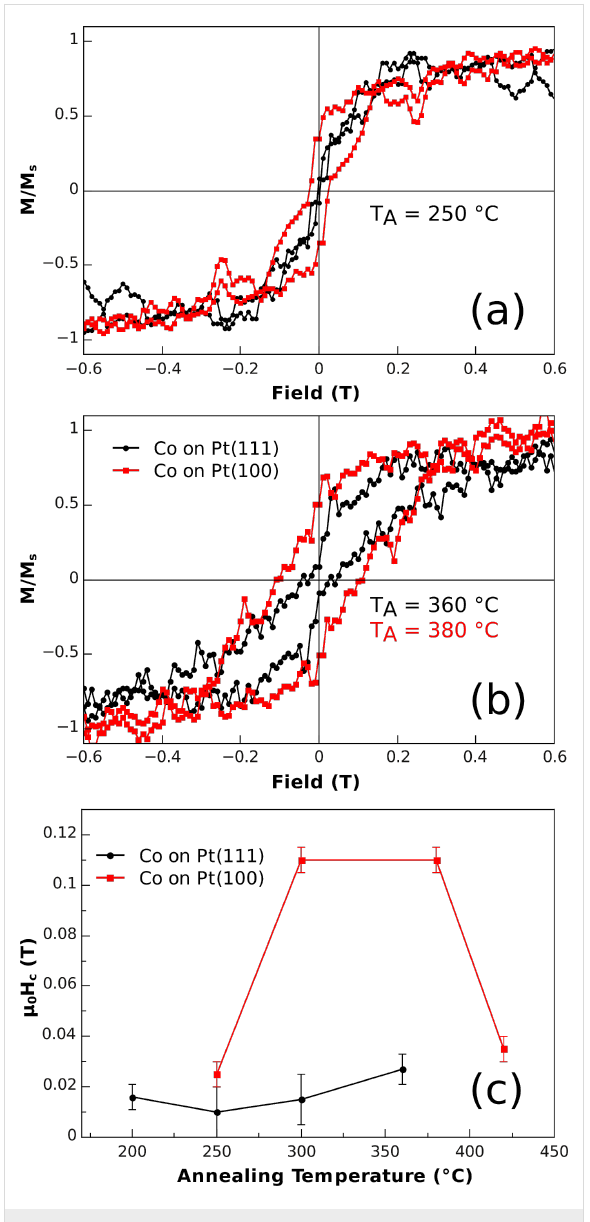
Figure 5: Element specific XMCD hysteresis loops measured at the Co L 3 maximum dichroic signal at T = 12 K and out-of-plane geometry for Co NPs on Pt(100) and Pt(111) films after annealing at (a) T A = 250 °C and (b) 360 °C on Pt(111) and 380 °C on Pt(100). Panel (c) shows the evolution of the coercive field as function of the annealing temperature (holding time at each T A : 30 min). The lines are given as guides to the